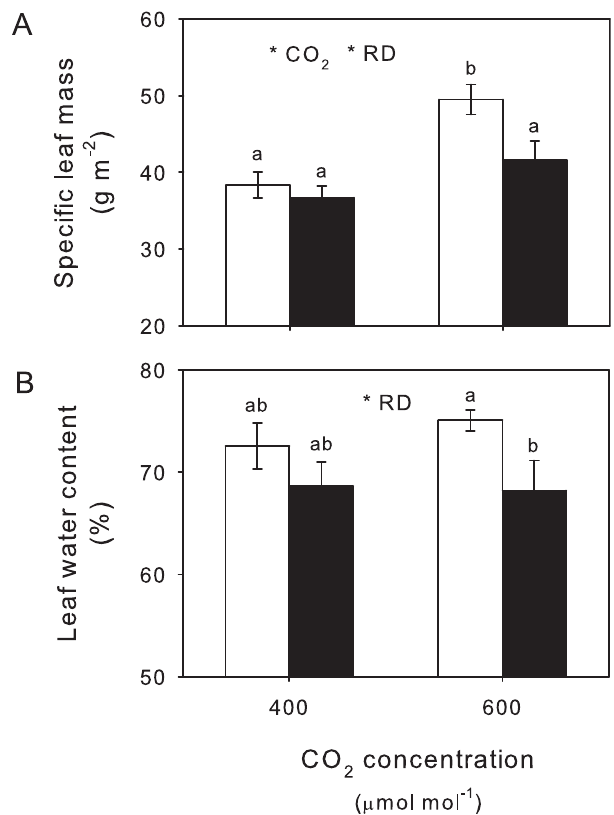
Figure 3. Leaf traits as affected by CO 2 and root damage. Effects of aCO 2 and eCO 2 on (A) specific leaf mass and (B) leaf water content (%) with (closed bars) and without (open bars) root damage (RD). Mean values 6 S.E. shown, N=24. Statistical significance of treatments indicated *( P , 0.05) with lowercase superscript letters indicating significant differences ( P , 0.05) between treatments.